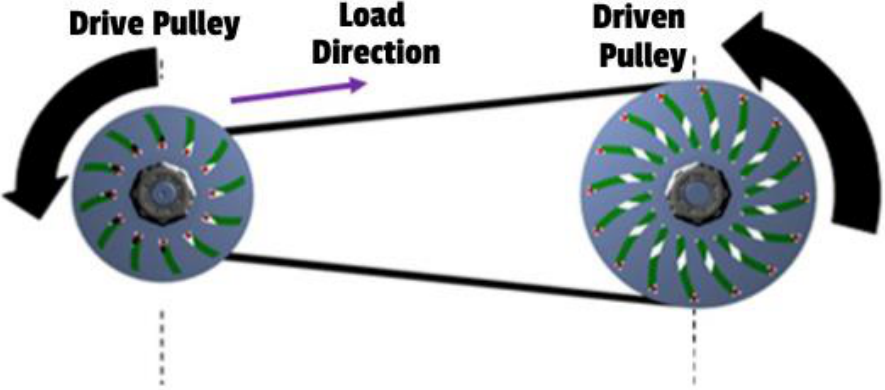
Figure 9. CVT operation principle, currently implemented at most hybrid or battery electric vehicles and electric scooters [76].